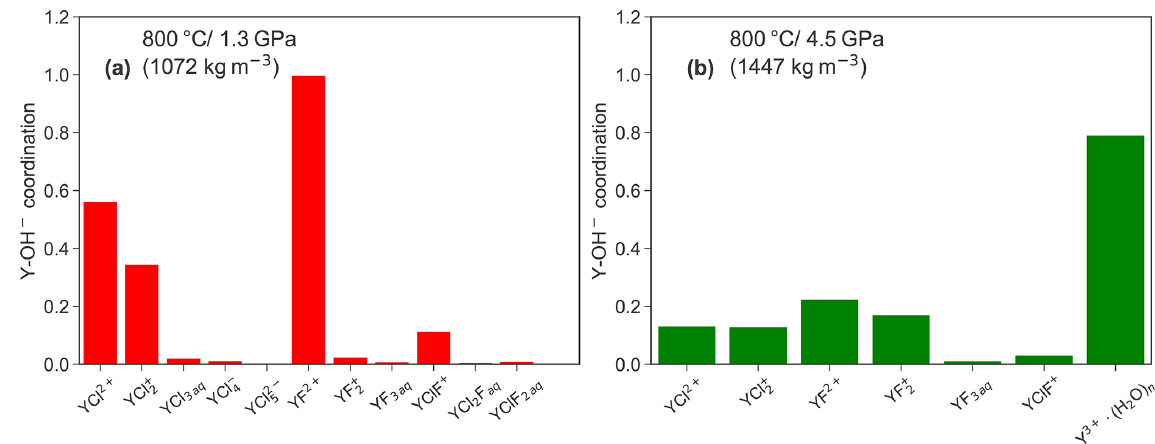
Figure 10. Comparison of the average Y − OH − coordination number between the different complexes that exist for at least over 10ps in the unconstrained AIMD at 1.3 (a) and 4.5GPa (b)